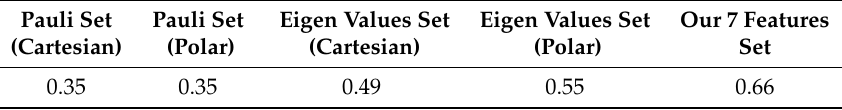
Table 6. F1 score for vertical distribution for different feature